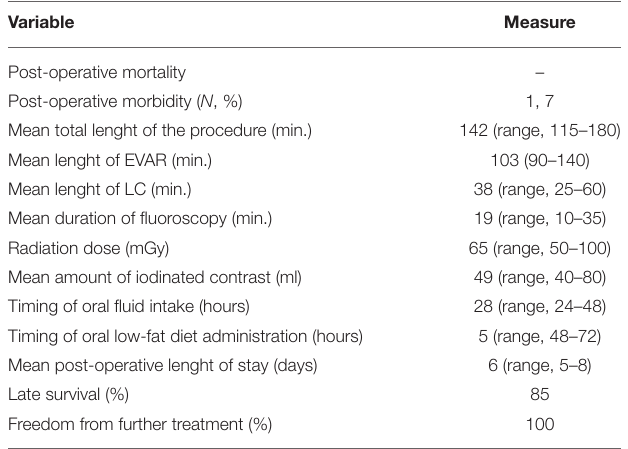
TABLE 2 | Endpoints of the